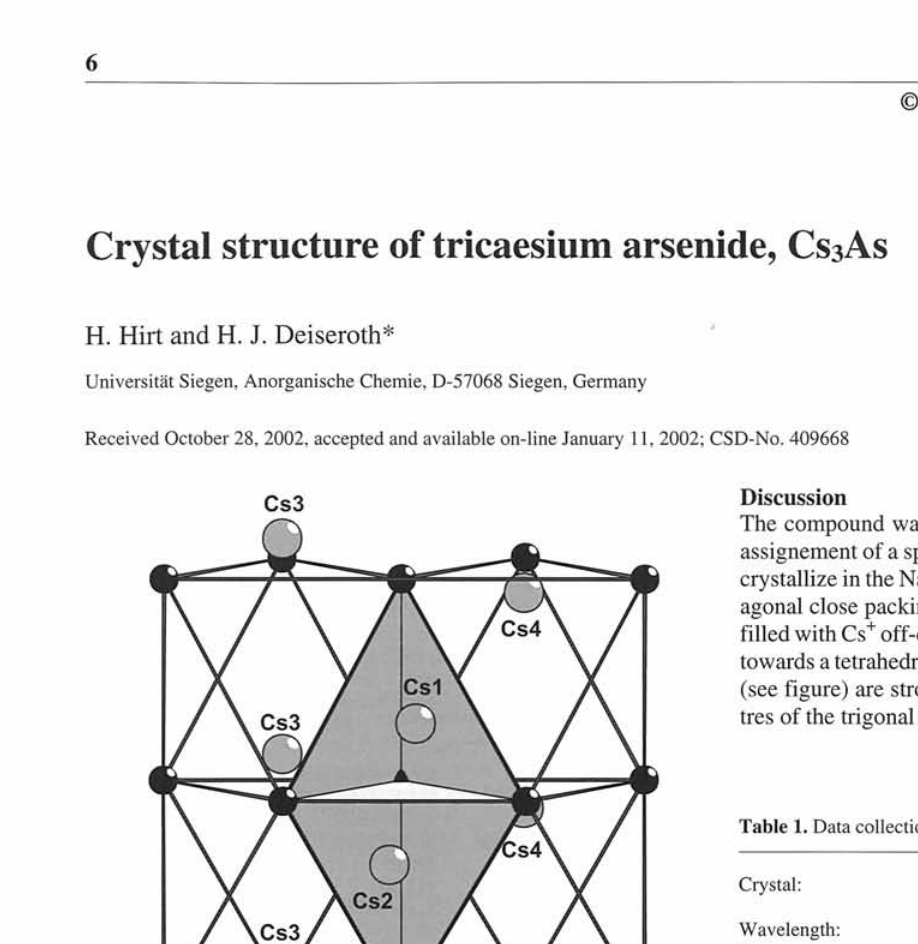
Table 1. Data collection and